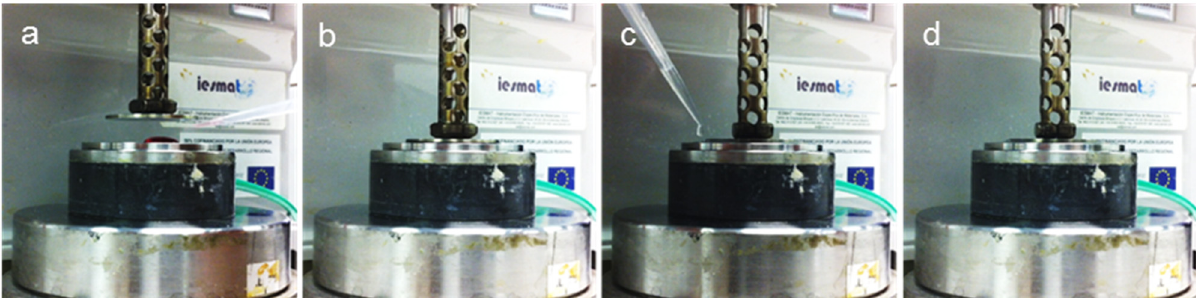
Figure 2. Image sequence of the gel filling process on the rheometer. Once the sample was mixed, it was pipetted in situ onto the rheometer plate ( a ); then, the gap was adjusted ( b ), and the sample was covered with oil ( c ) to prevent evaporation; the set-up was then ready to conduct the experiment ( d ).